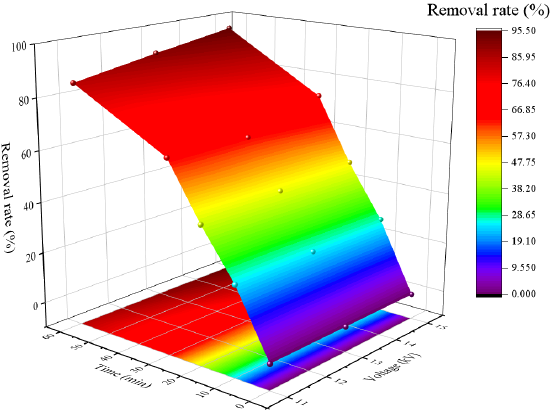
Figure 2. The influence of voltage on the removal rate of MO.